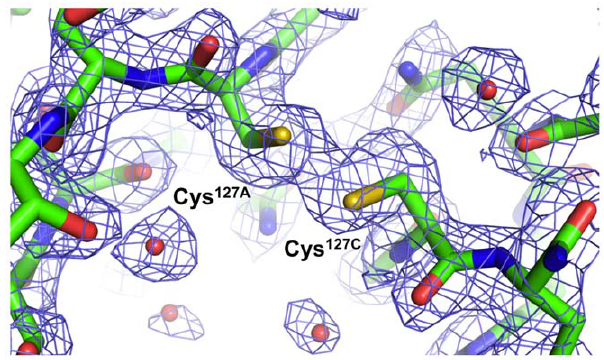
Figure 6. Electron density map (2| F o |-| F c | coefficients, con- toured at 1.1 sigma) contoured around the model of the disulfide bond formed by Cys-127 residues from adjacent subunits (A and C or B and D in the tetramer shown in Figure 5). Coefficients and phases were calculated using Refmac and the figure was prepared using